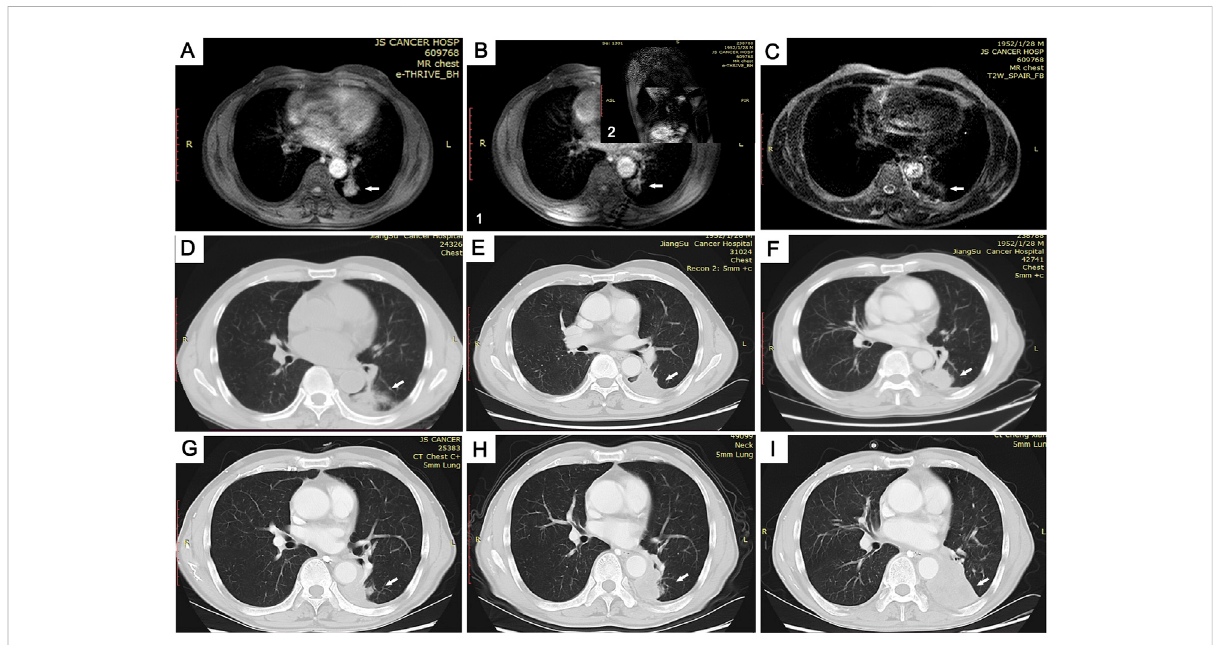
FIGURE 3 Images of the MRI-guided MWA procedure and follow-up in 69-year-old man with pulmonary adenocarcinoma in inferior lobe of left lung. (A) Tumor lesion seen on MRI immediately prior to MWA. (B) Combined with axial (1) and sagittal (2) MRI scans, the ablation needle reached the tumor site (C,D) . By comparing T2WI MRI scan images (C) and lung window CT images (D) , we found MRI to be more accurate in the assessment of microwave-ablation boundaries. ( E-I) Follow-up CT scans at 3 (E) , 6 (F) , 12 (G) , and 20 (H) months showed no change in the GGO size. At the 26-month follow-up (I) , the tumor size was